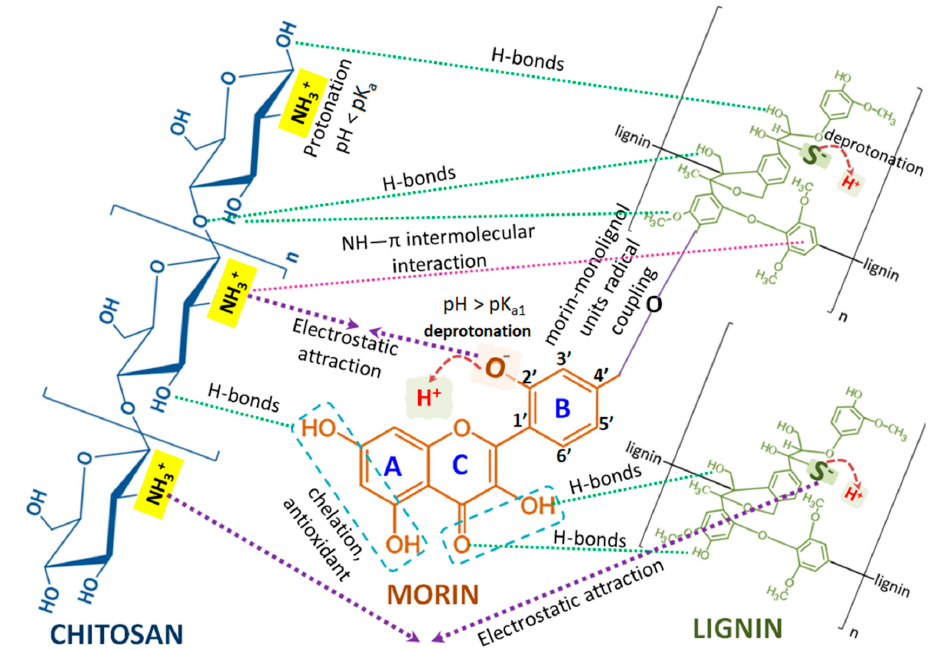
Figure 5. Scheme of the possible intermolecular interactions between morin, chitosan and lignin. According to the scientific data, the interaction of chitosan with teichoic acids in S. aureus cell walls provoked inhibition of bacterial growth up to approximately 100% [20].